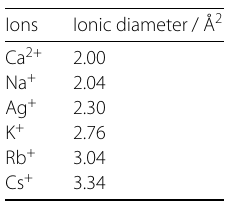
Table 2 Ionic diameters of metal guest ions studied in the present study. Coordination number is 6 [41]